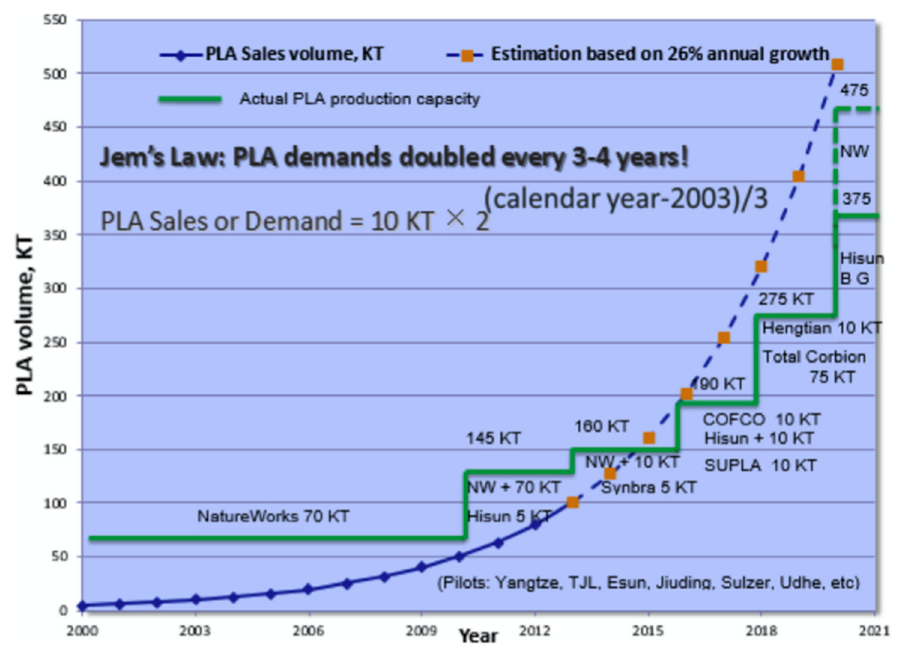
Figure 14. The Global PLA Plant Capacity vs. the Market Demand Predicted by Jem’s Law [9].